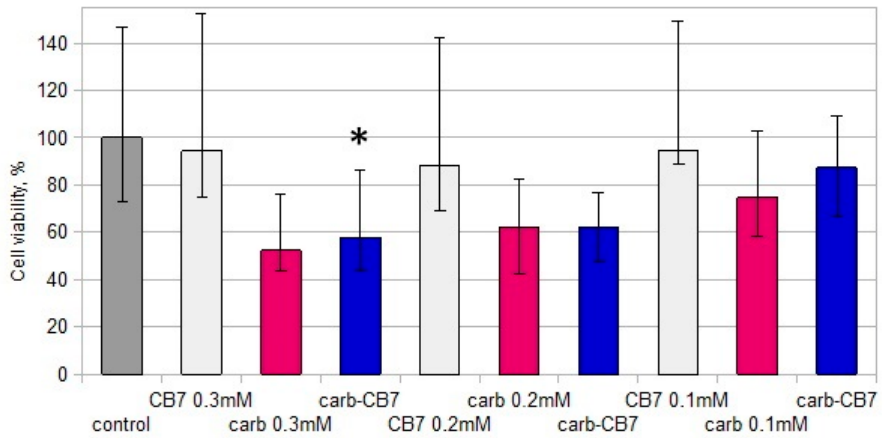
Figure 5. Effects of the CB[7] and platinum drugs on cell viability of PBMCs from patients with B-cell lymphomas.* Indicates a significant difference ( p < 0.05) vs. carboplatin. Oxaliplatin and oxaliplatin–CB[7] complex, as well as carboplatin and mixture of carboplatin with CB[7] (1: 1), did not affect the spontaneous proliferative activity of the PBMCs, but at the same time, they suppressed the anti-CD3-induced proliferative response, indicating an immunosuppressive effect on activated lymphocytes (Tables 1 and 2). Table 1. The relative number and level of spontaneous proliferation of various subpopulations of PBMCs.